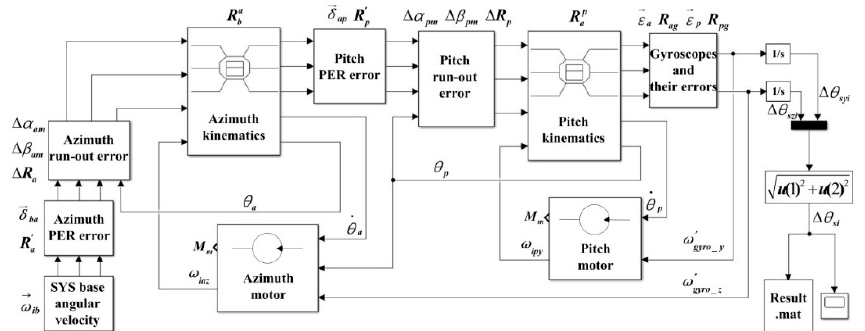
Figure 14. Overall simulation modeling of the system stability accuracy.